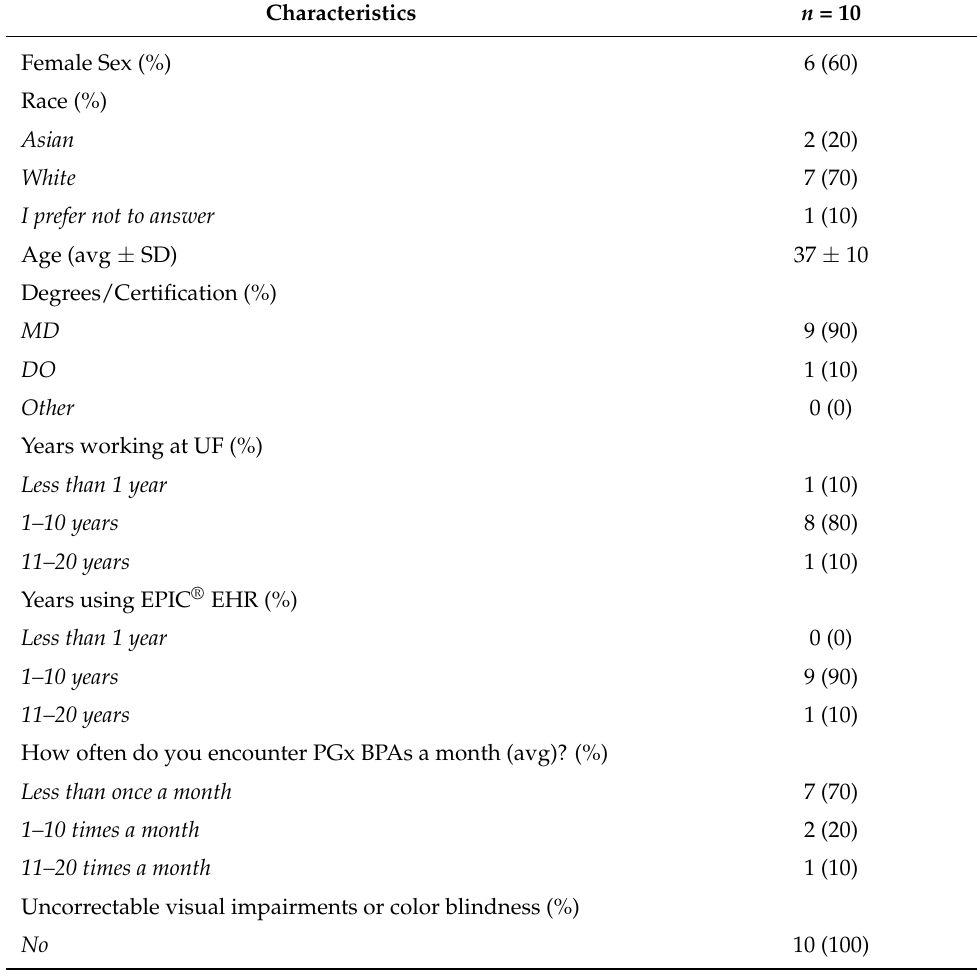
Table 2. Characteristics of the ten healthcare